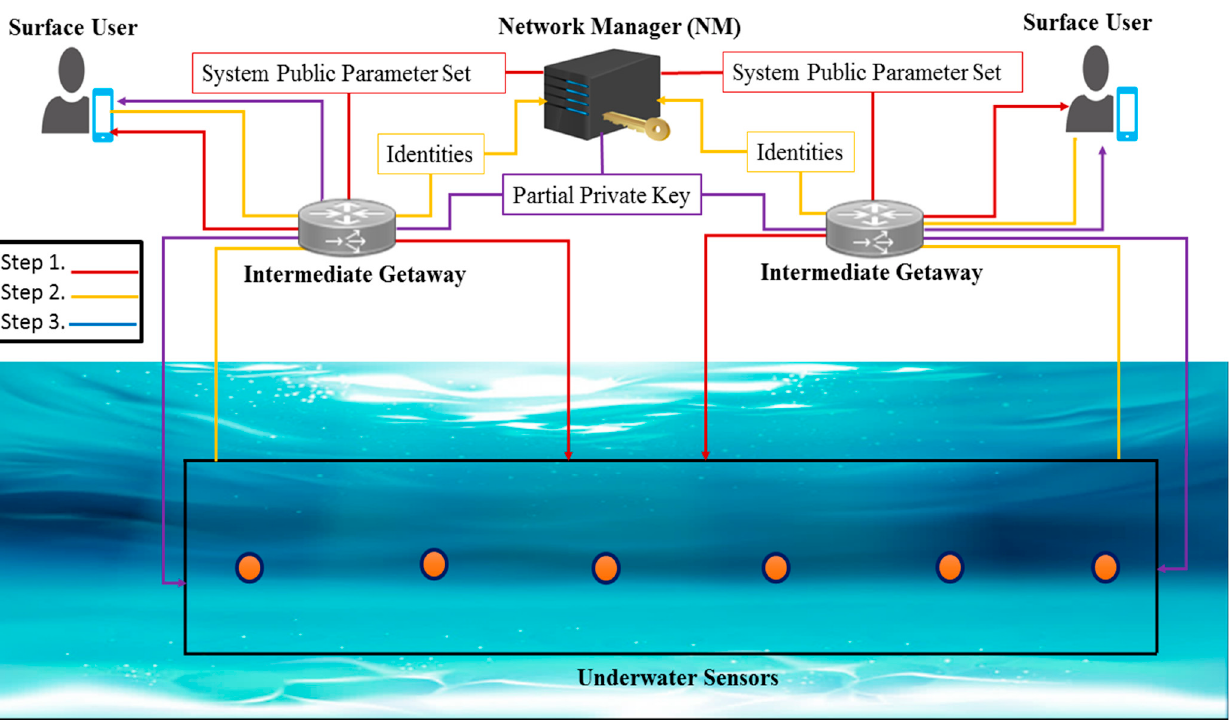
Figure 2. Proposed network model.